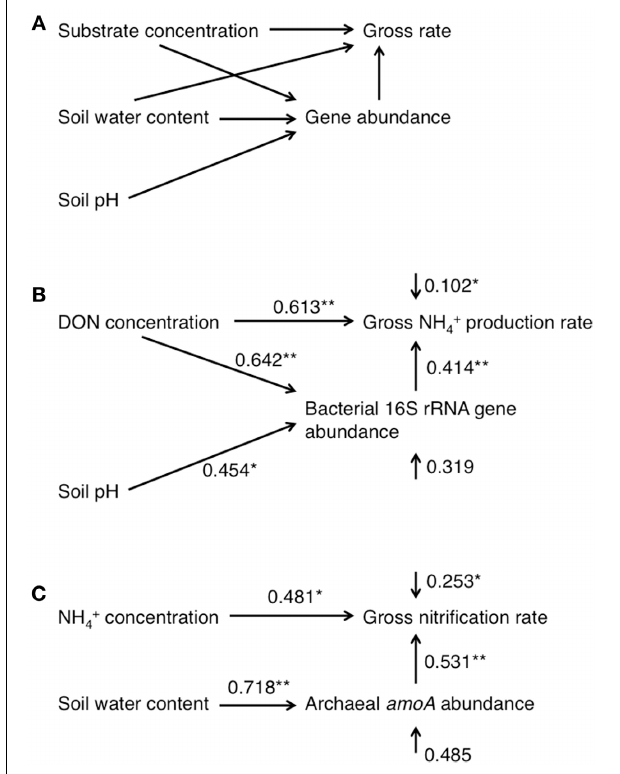
FIGURE 1 | Path diagrams representing the full model (A) and the final models used to describe the patterns observed in the gross NH + 4 production rate (B) and gross nitrification rate (C). The numbers associated with the arrows between two variables are the partial regression coefficients derived from multiple regressions. The numbers associated with the arrows of single variables represent the unexplained variation (1- R 2 ), which represent the effects of unmeasured variables and measurement error. All pathways are significant in the final model ( ∗ p < 0 . 05; ∗∗ p < 0 .